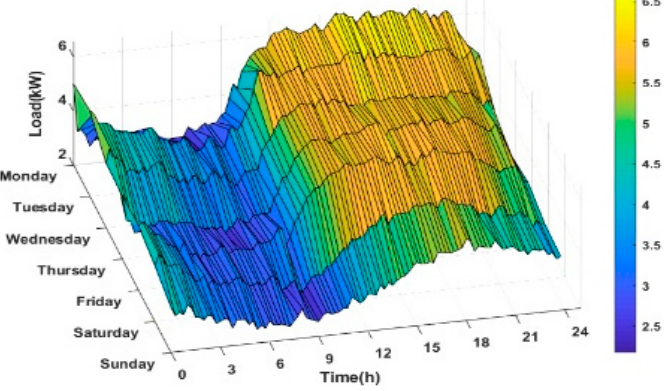
Figure 19. Testbed demand load profile.